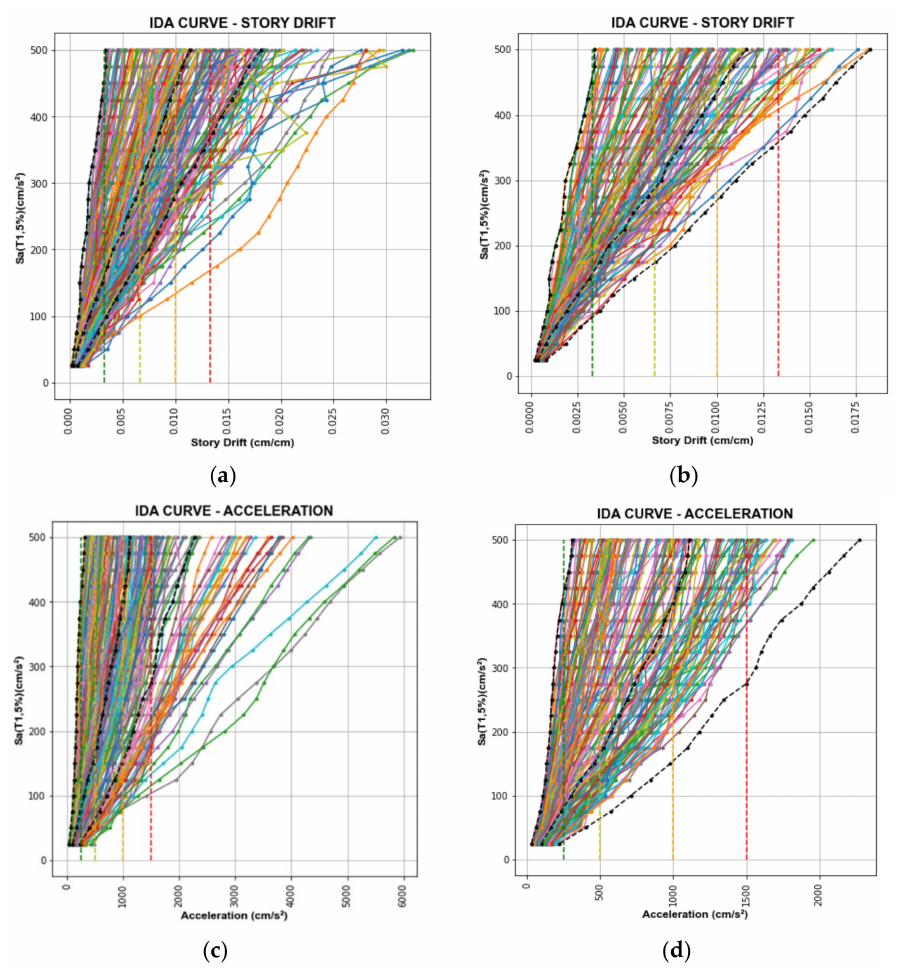
Figure 11. IDA Curves of Toyohashi Fire Station Building. ( a ) IDA curves of the database for SD; ( b ) IDA curves of selected records for SD; ( c ) IDA curves of the database for AA; ( d ) IDA curves of selected records for